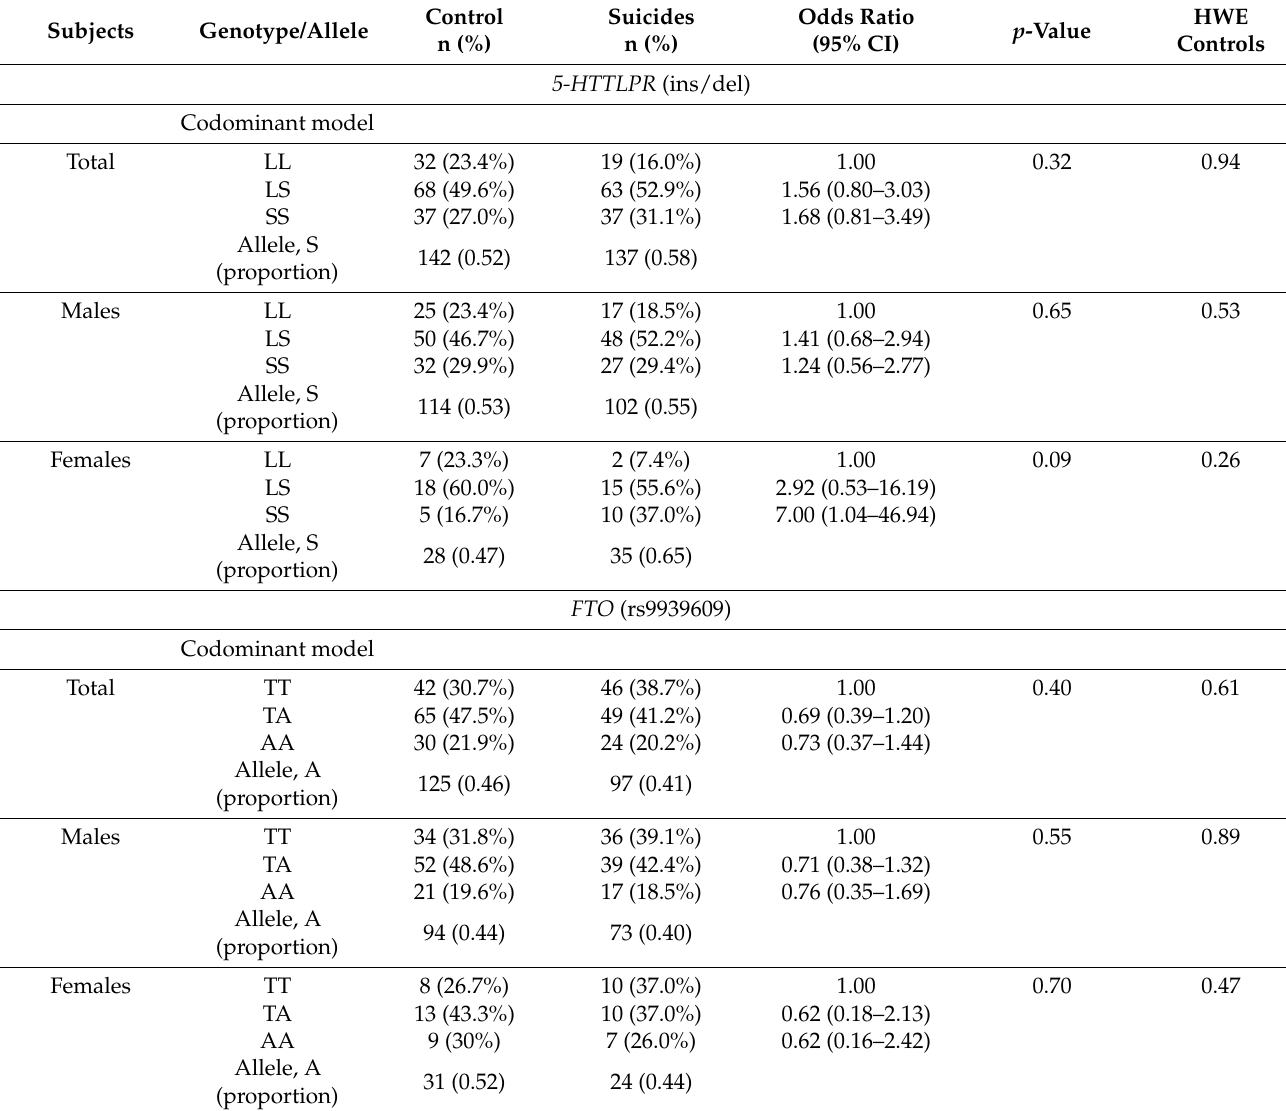
Table 4. Distribution of genotypes and analysis of the association between 5-HTTLPR (ins/del) and FTO (rs9939609) gene variants and suicide